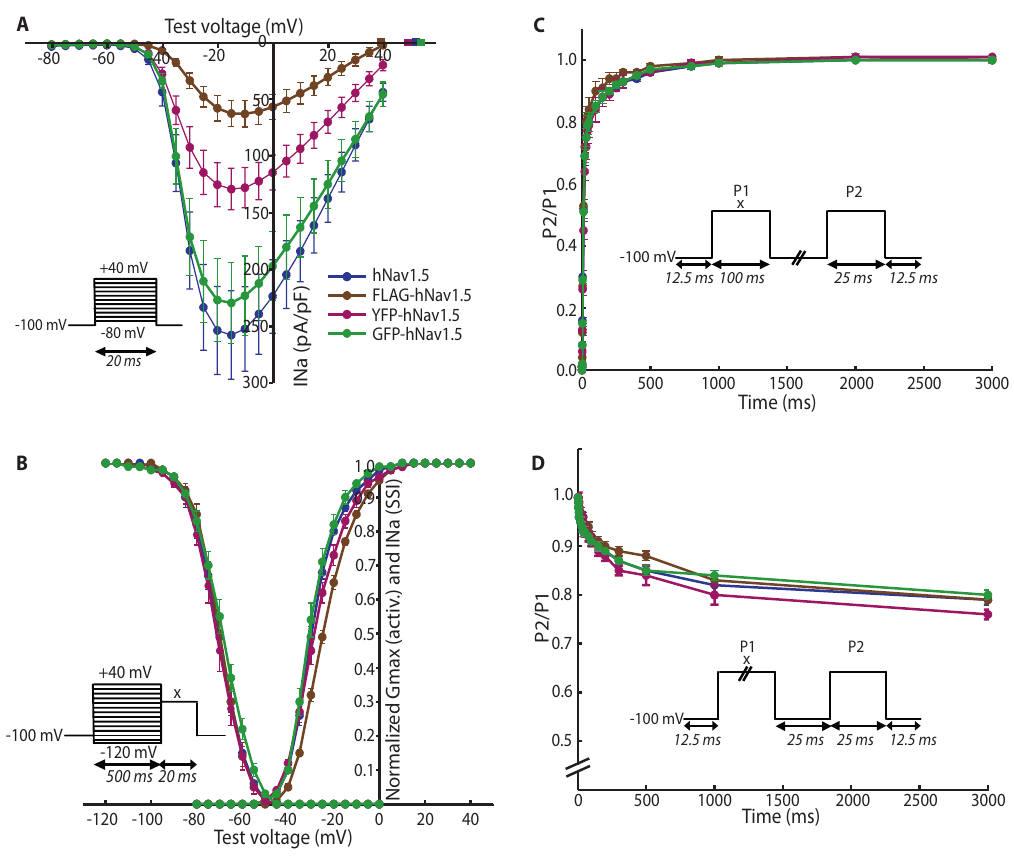
Figure 4. Electrophysiological properties of untagged and tagged hNa 1.5 . The voltage-clamp protocols used are shown in the v corresponding insets. For B–D , the voltage x was adjusted to the voltage that elicited maximum current during the current voltage (I/V)- protocol. ( A ) I/V-protocol for assessment of reversal potentials. Tagging with N-terminal YFP and FLAG (L299/V300) significantly decreases peak currents. Calculated reversal potentials are marked with square data points. ( B ) Voltage-dependence of activation and steady-state inactivation. The data was fitted with the Boltzmann formula. The activation slope of FLAG- and YFP-tagged channels is shallower compared to the untagged